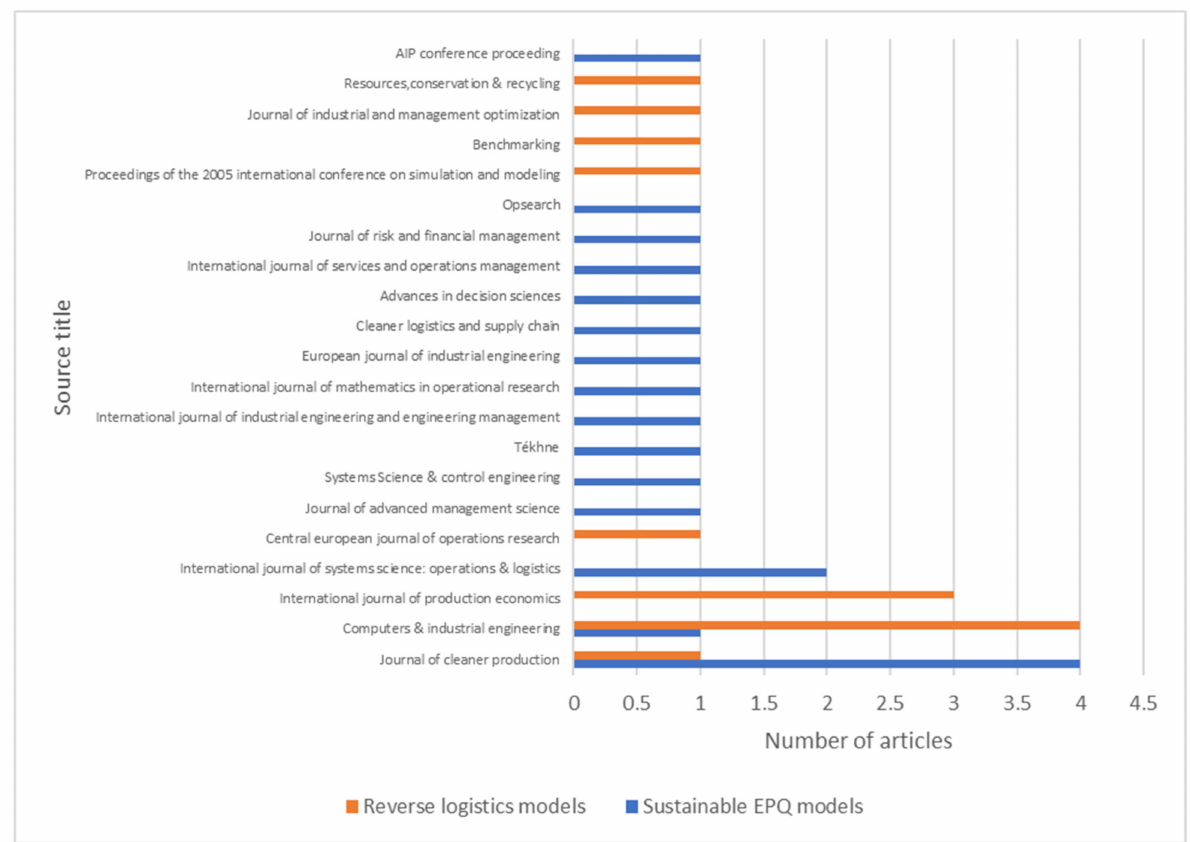
Figure 3. Number of articles per